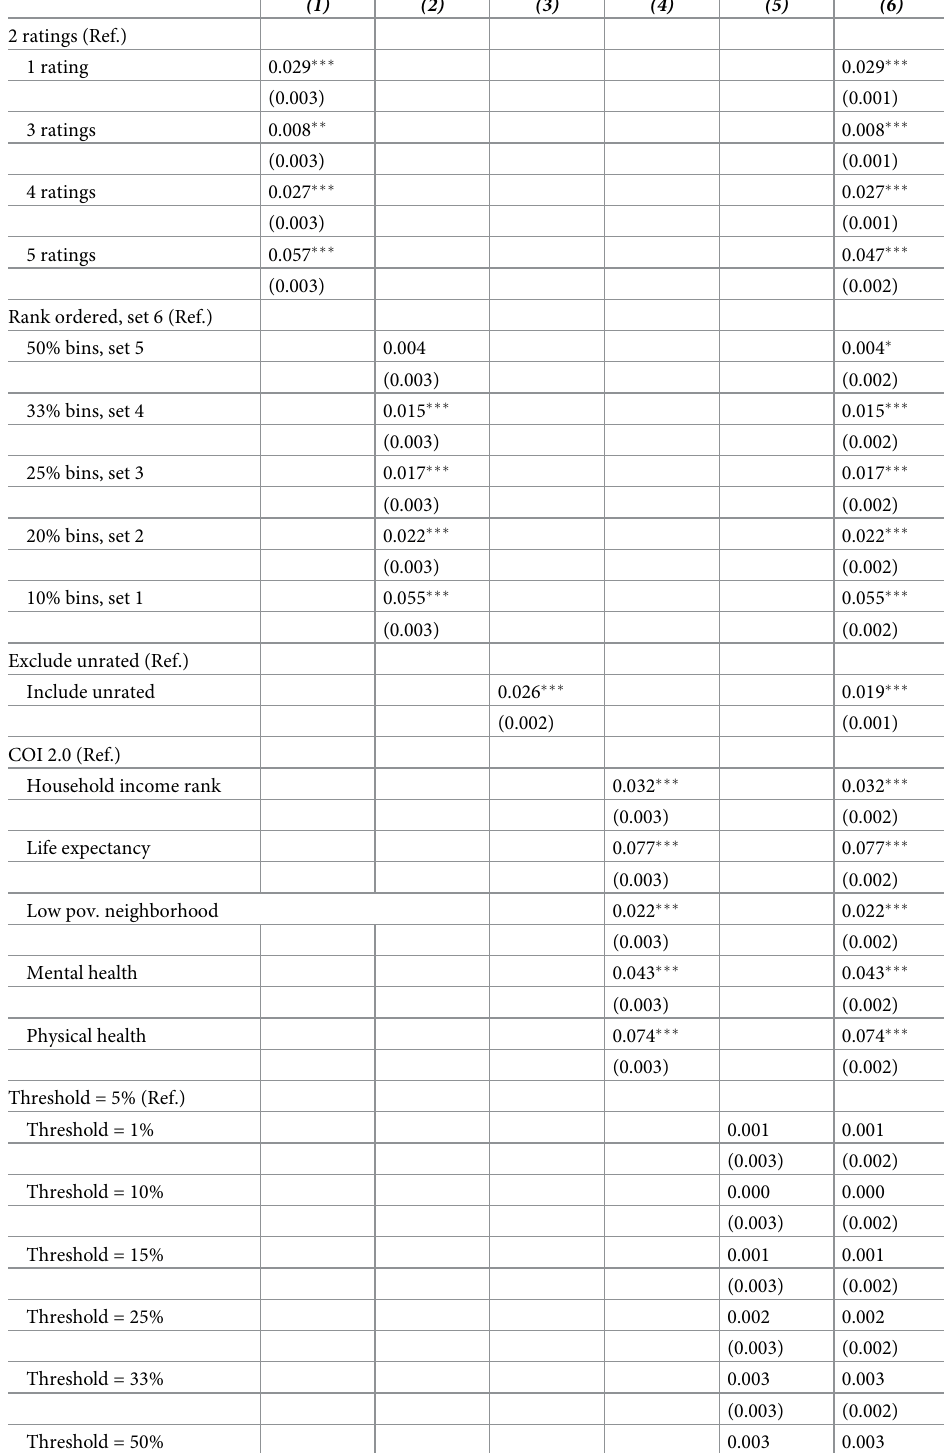
Table 3. OLS regression coefficients from regressions of cross-validated mean squared prediction errors on exper- iment features, based on 2,628 cross-validation